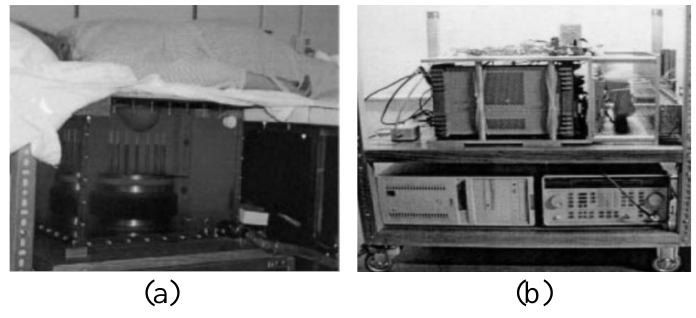
Figure 3. Prototype of the imaging system developed by Meaney et al. [44]. ( a ) View of the examination table. ( b ) View of the data acquisition system including the microwave source. Reprinted with permission from